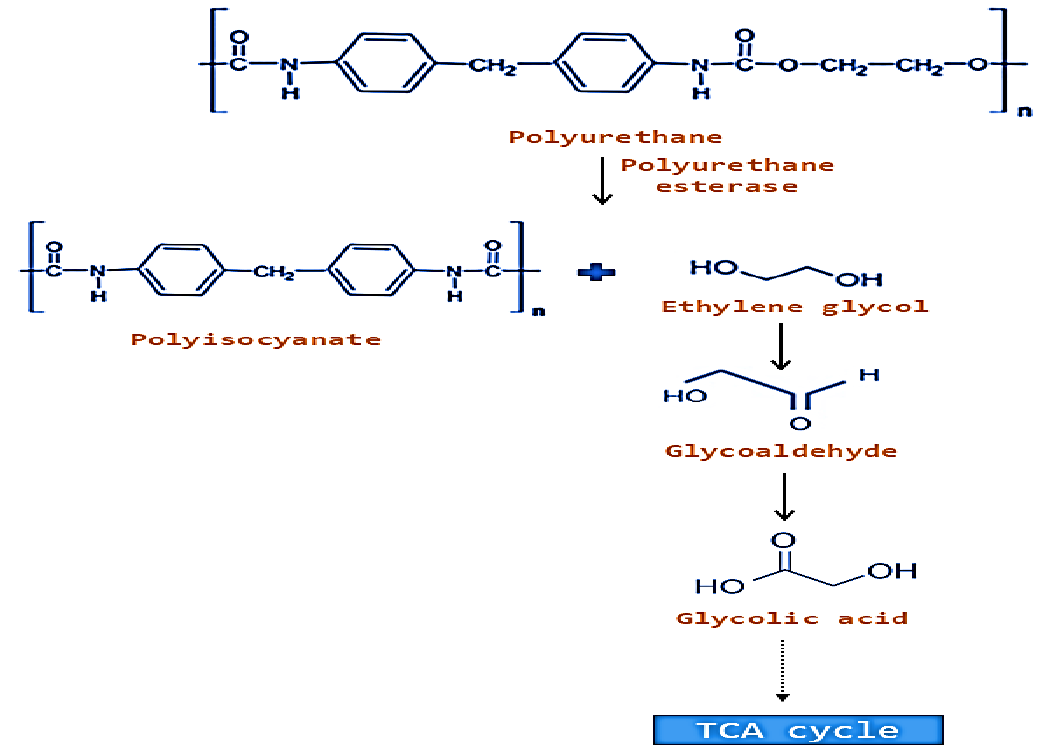
Figure 6. Enzymatic reactions involved in biodegradation of polyurethane (PU). The enzyme PU esterase is the enzyme that helps in biodegradation of PU to polyisocyanate and ethylene glycol. Finally, the produced glycolic acid enters into TCA cycle.